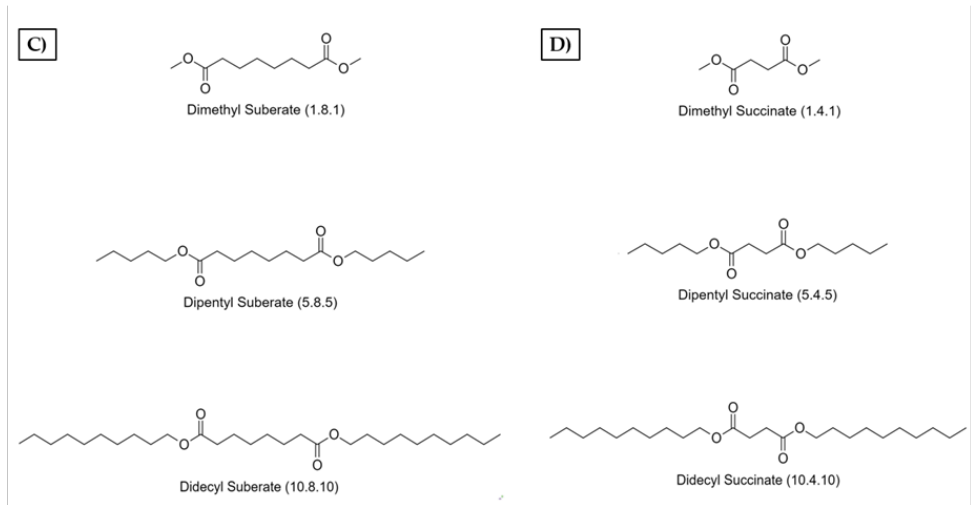
Figure A1. Chemical structures and IUPAC names of the diesters presented in this study grouped by dicarboxylic acid of origin. In particular, ( A ) oxalic diesters, ( B ) sebacic diesters, ( C ) suberic diesters, and ( D ) succinic diesters. The carbon number of the corresponding precursor dicarboxylic acid and alcohol are reported in brackets. For example, DiMeOHOx is the product of two methyl groups (C 1 ) attached at the extremes of a central oxalic acid molecule (C 2 ). Therefore, it is indicated as 1.2.1.